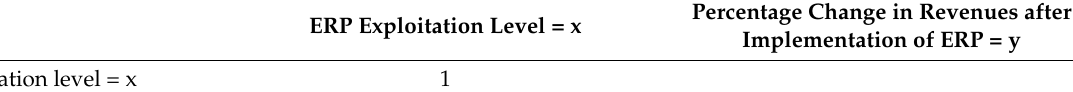
Percentage Change in Revenues after Implementation of ERP = y